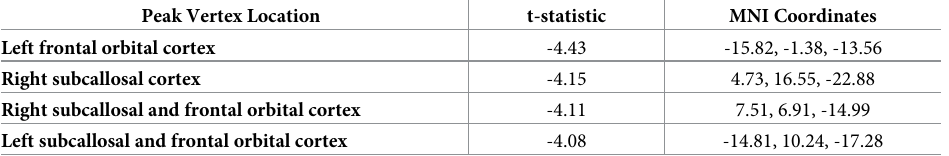
Table 2. Peak areas from variable-centered analysis. Peak areas in which local cerebral cortical thickness was associ- ated with the continuous measure of amygdalar activation (i.e., angry minus neutral face contrast) in a second-order (quadratic) model over the whole